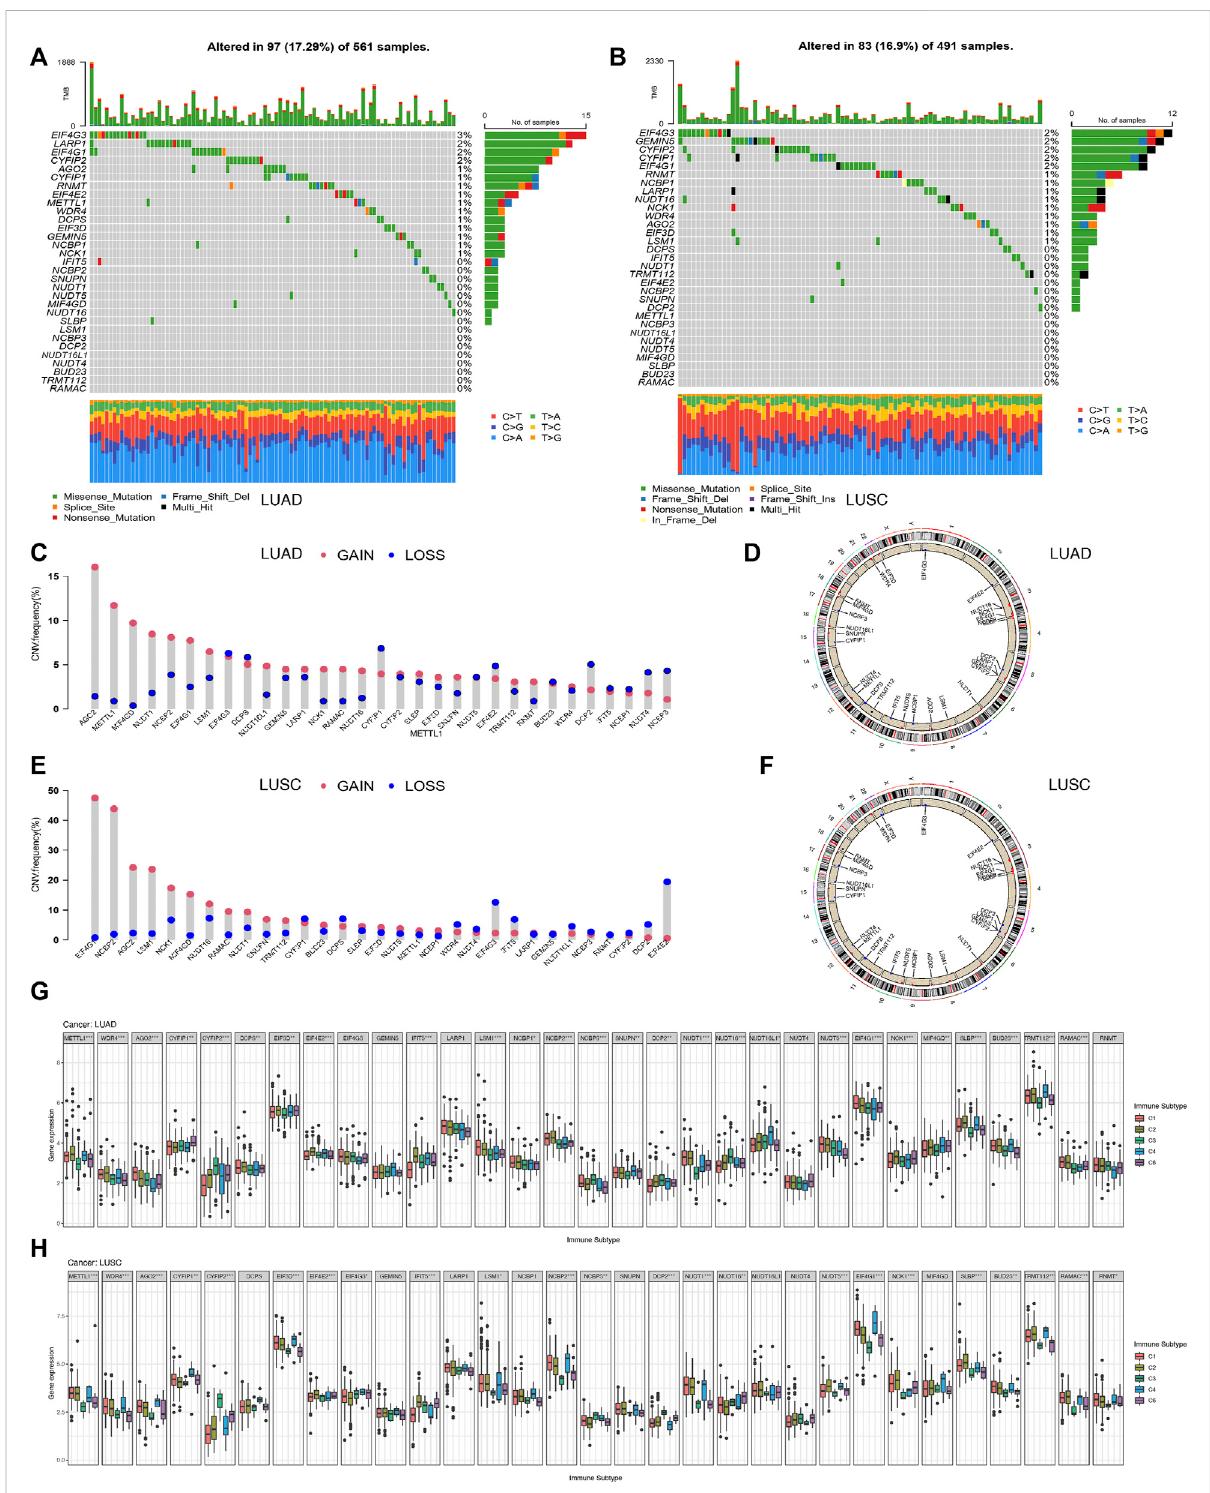
FIGURE 5 Correlation analysis between the expression of 31 m7G regulators and clinical features in LUAD and LUSC. (A) Mutation frequencies of 31 m7G regulatorsin97and83patientswithLUAD. (B) Mutationfrequenciesof31m7Gregulatorsin97and83patientswithLUSCfromtheTCGAcohort. (C) Frequencies of CNV gain, loss, and non-CNV among m7G regulators in LUAD patients. (D) Chromosomal locations of CNV changes in m7G regulators in LUAD patients. (E) Frequencies of CNV gain, loss, and non-CNV among m7G regulators in LUSC. (F) Chromosomal locations